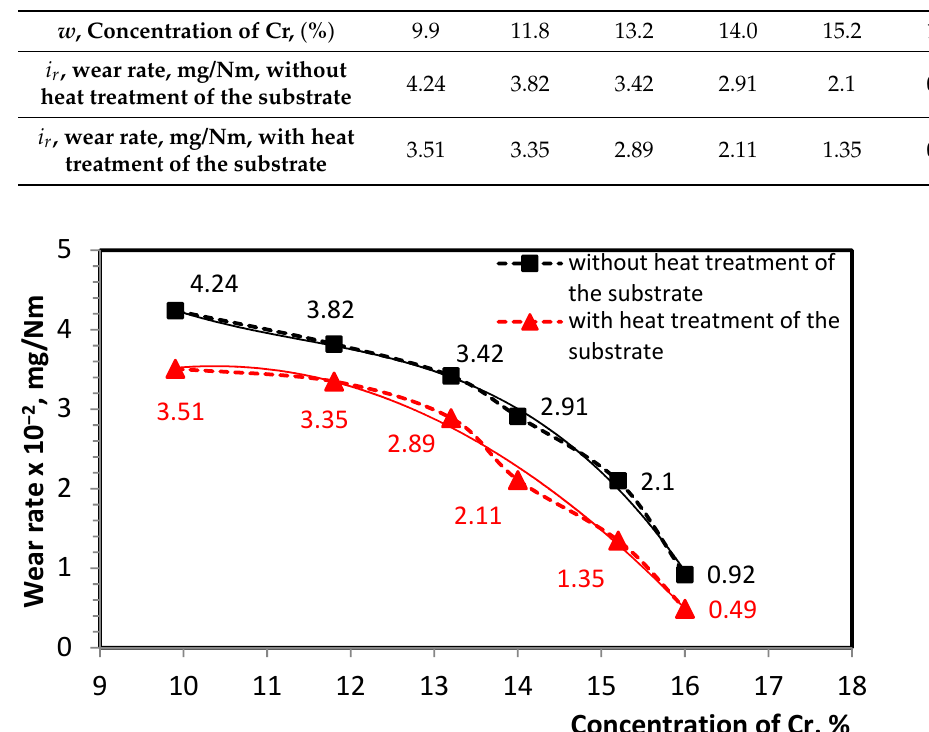
Figure 15. Dependence of wear rate on chromium concentration range from 9.9% to 16%.